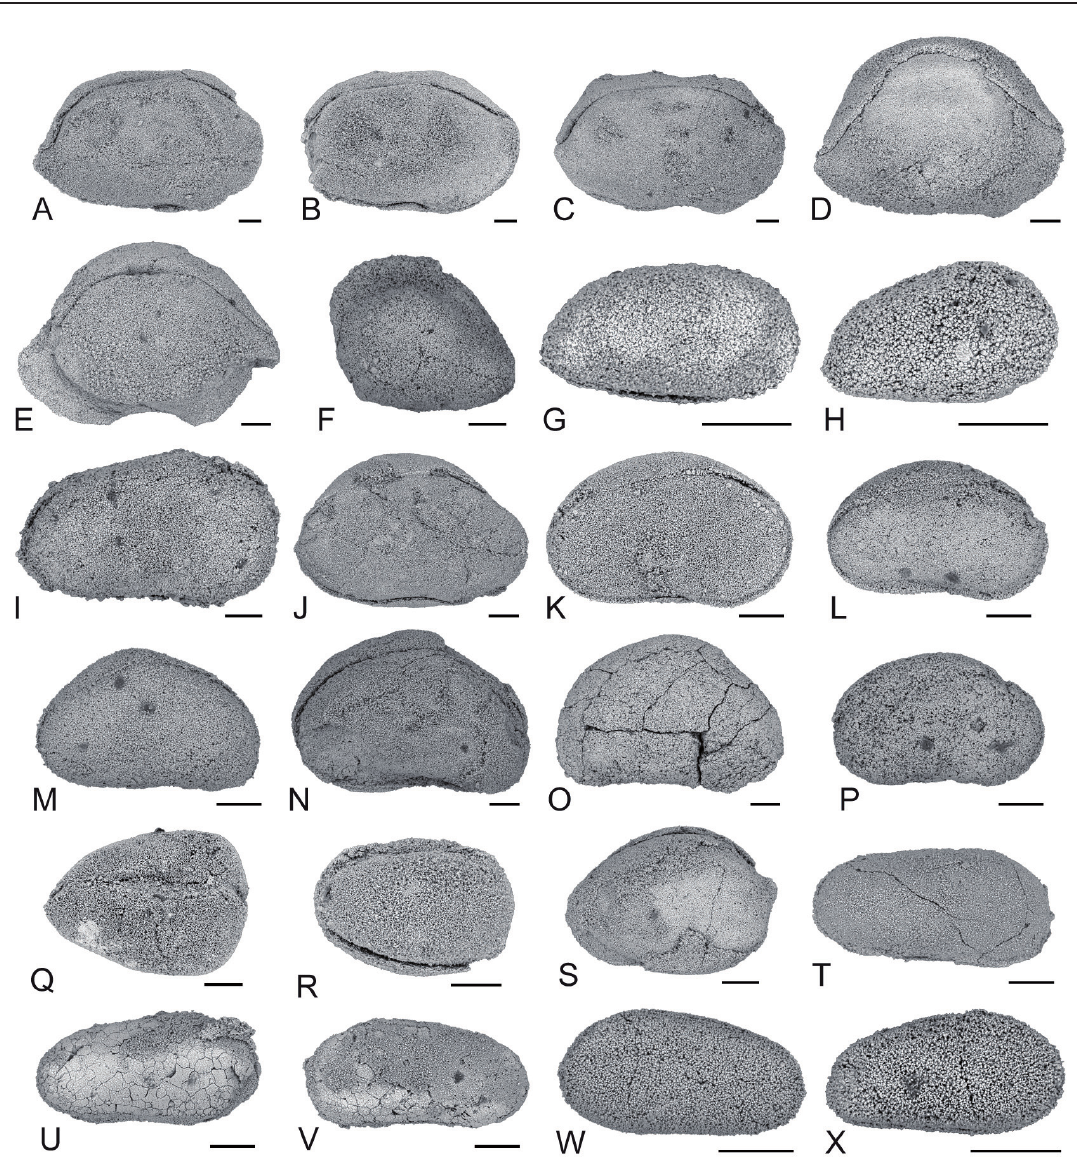
Fig. 13. Ostracods from the Dajiang section, South China. — A–B . Petasobairdia sp. 1. A . Carapace, right lateral view, P6M3082. B . Carapace, right lateral view, P6M3083. — C . Petasobairdia sp. 2, carapace, right lateral view, P6M3084. — D–E . Petasobairdia sp. 3. D . Carapace, right lateral view, P6M3085. E . Carapace, right lateral view, P6M3086. — F . Petasobairdia ? sp. 4, carapace, right lateral view, P6M3087. — G . Spinocypris sp. 1, carapace, right lateral view, P6M3088. — H–I . Spinocypris ? sp. 2. H . Carapace, right lateral view, P6M3089. I . Carapace, right lateral view, P6M3090. — J . Kempfina sp. 1, carapace, right lateral view, P6M3091. — K–L . Silenites sp. 1. K . Carapace, right lateral view, P6M3092. L . Carapace, right lateral view, P6M3093. — M-N . Silenites sp. 2. M . Carapace, right lateral view, P6M3094. N . carapace, right lateral view, P6M3095. — O . Silenites sp. 3, carapace, right lateral view, P6M3096. — P . Silenites sp. 4, carapace, right lateral view, P6M3097. — Q . Microcheilinella cf. venusta Chen, 1958, carapace, dorsal view, P6M3132. — R . Microcheilinella sp. 1, carapace, right lateral view, P6M3131. — S . Cetollina ? sp. 1, carapace, right lateral view, P6M3098. — T–X . Paracypris gaetanii Crasquin–Soleau, 2006. T . Carapace, right lateral view, P6M3099. U . Carapace, right lateral view, P6M3100. V . Carapace, left lateral view, P6M3101. W . Carapace, left lateral view, P6M3102. X . Carapace, right lateral view, P6M3103. – Scale = 100